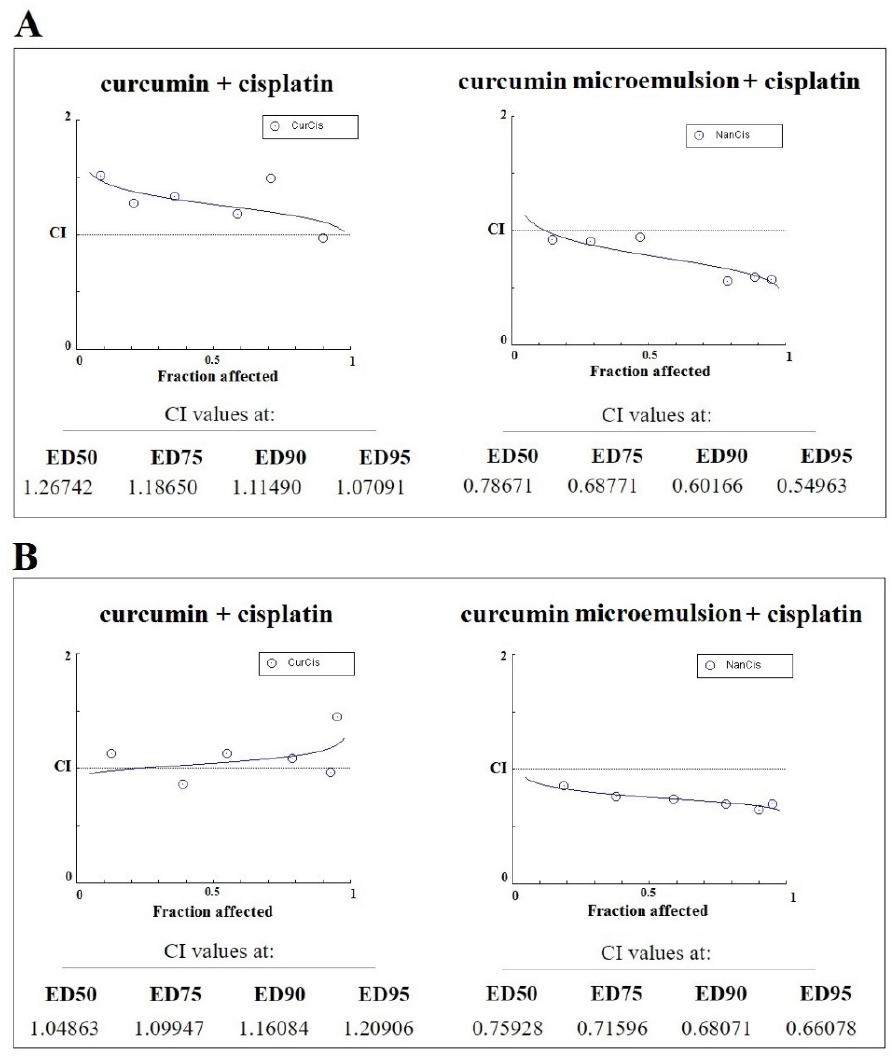
Figure 5. Analysis of drug interaction between free or encapsulated curcumin and cisplatin in ( A ) HepG2 and ( B ) MCF7 cancer cells in different effective doses (EDs).